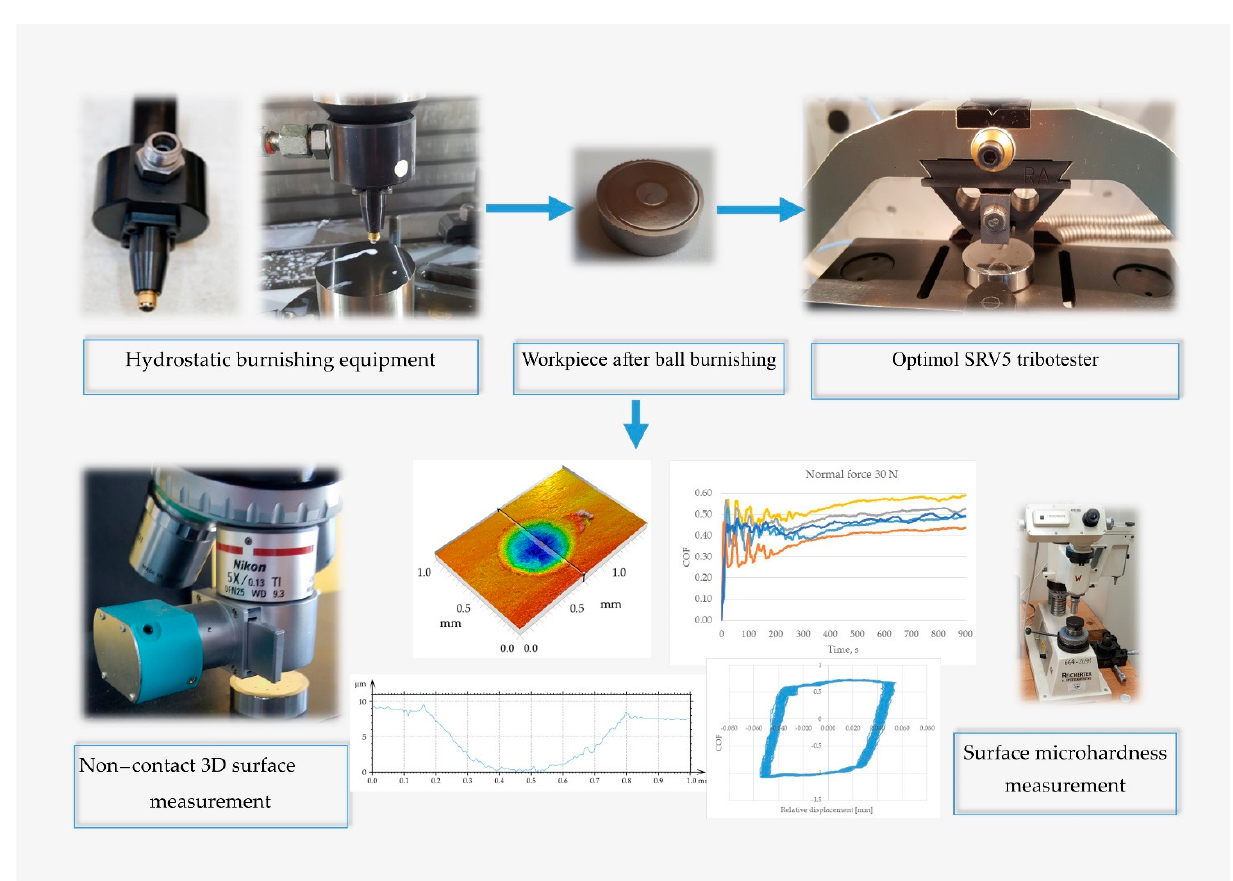
Figure 1. A scheme of the experimental arrangement.